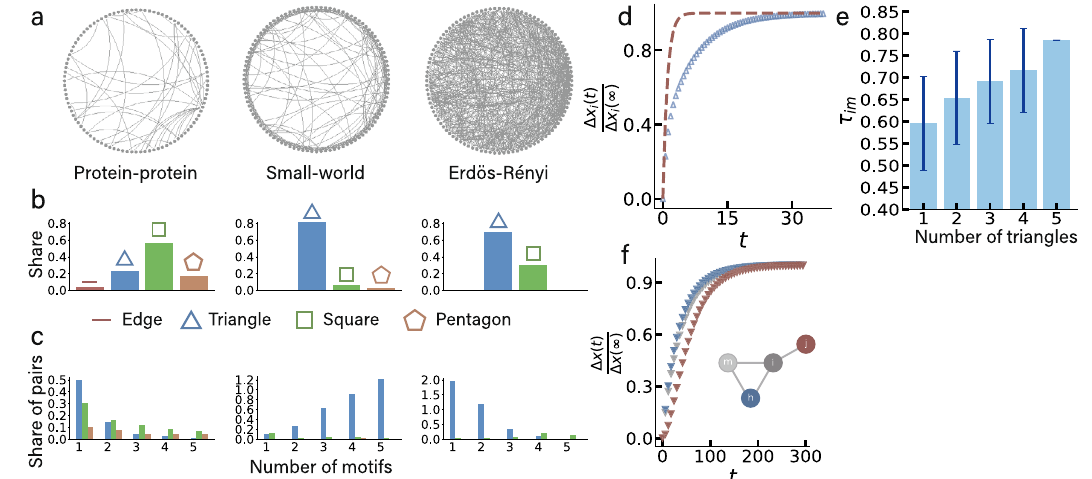
Fig. 1 | Prevalence and dy5gnamical impact of motifs in random networks. a From left to right: Schematic plot of protein-protein network (shown for N =100 nodes from total N =2035) 35 , small-world network, and Erdös-Rényi (ER) network with network size N =100 and average degree 10. b Share of motifs (edges, trian- gles, squares, pentagons) for a network. Triangles play important roles, no matter forthe networks with denseorrandom connections,orhighly clusterednetworks. c Shareofedgesaspartofbasicmotifs(triangles,squares,pentagons).Theshareis calculated by the number of edges as part of corresponding motif divided by the networksize.Mostedgesformtriangles,andforthesmall-worldnetworkwithhigh clustering more and more edges form larger number of triangles, demonstrating the dominance of triangles. d Target nodes i as part of the (independent) edges (brown) respond faster than other target nodes i as part of triangles (blue), as